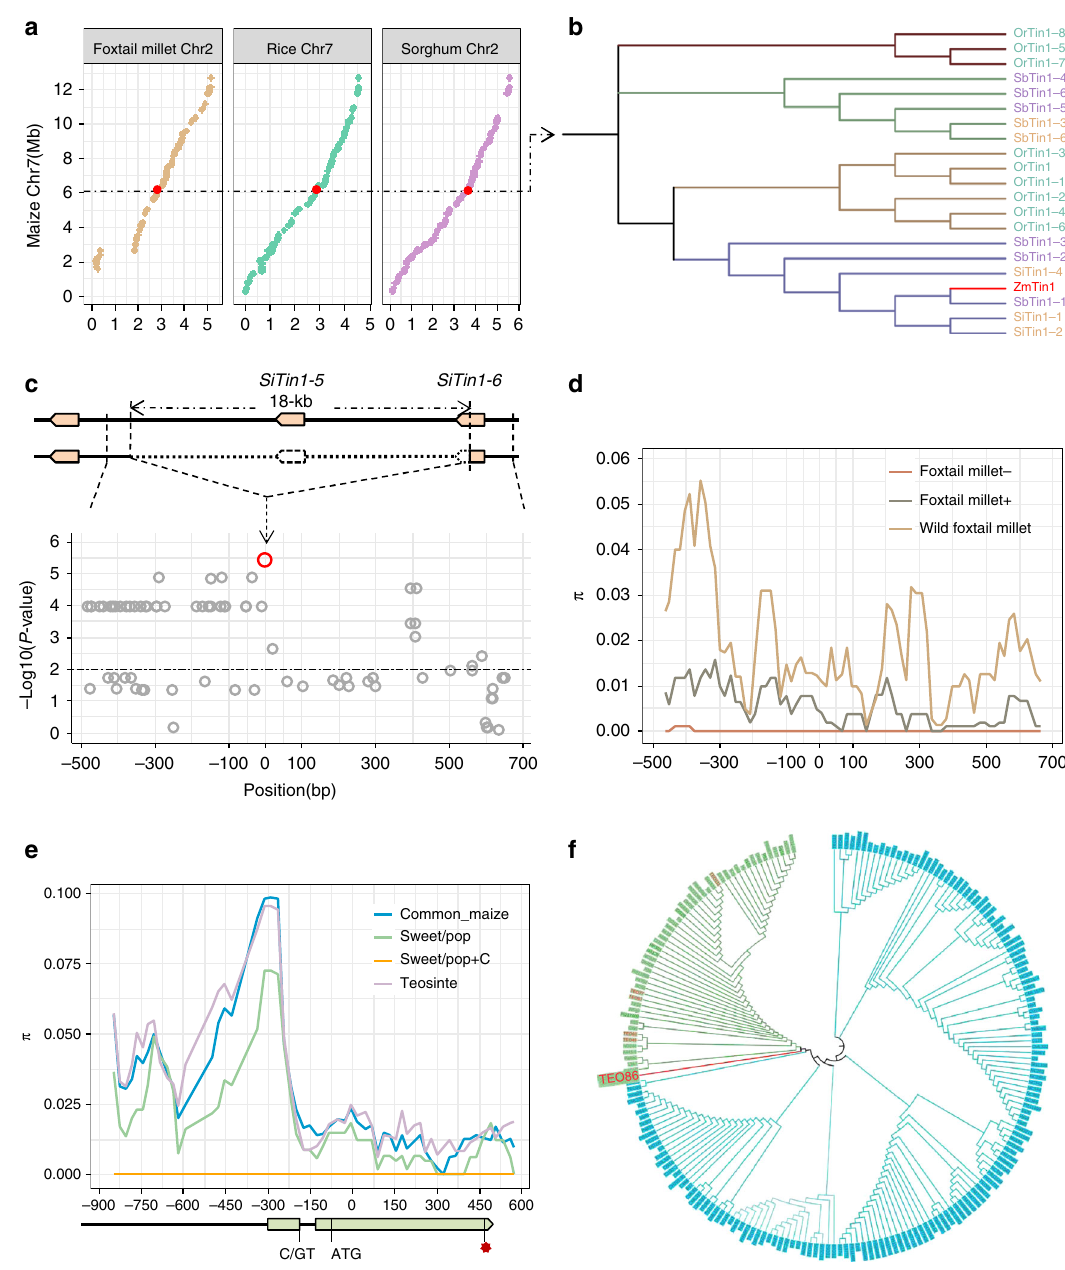
Fig. 6 Parallel selection of tin 1 among different species. a , Comparative genomic analysis of the tin1 locus among maize, rice, foxtail millet, and sorghum. Red dots represented the tin1 locus. b Phylogenetic tree for tin1 orthologs among different cereal species. Maize tin1 was marked in red. c Association mapping test between foxtail millet tin1 and tiller number. An 18-kb deletion containing one and a half tin1 copies was present in domesticated foxtail millet. The red dot signi fi ed the causal variant for tiller number. The horizontal red dashed line represents signi fi ed the 5% signi fi cance threshold with Bonferroni correction for 76 tests. d DNA diversity analysis for foxtail millet tin1 . The deletion break point was regarded as position 0. + and − , with and without the 18-kb sequence, respectively. e DNA diversity analysis for maize tin1 . The gene structure of tin1 was shown on the horizontal axis, the start codon was set as position 0. + C, with the splice-site variant of C/GT. Red star, stop codon. f Phylogenetic tree analysis for maize tin1 in a global natural maize population. The teosinte lines with the splice-site variant of tin1 were highlighted in